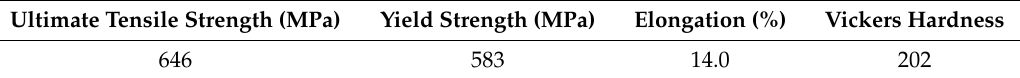
Table 2. Mechanical properties of CuNi 2 Si alloy.